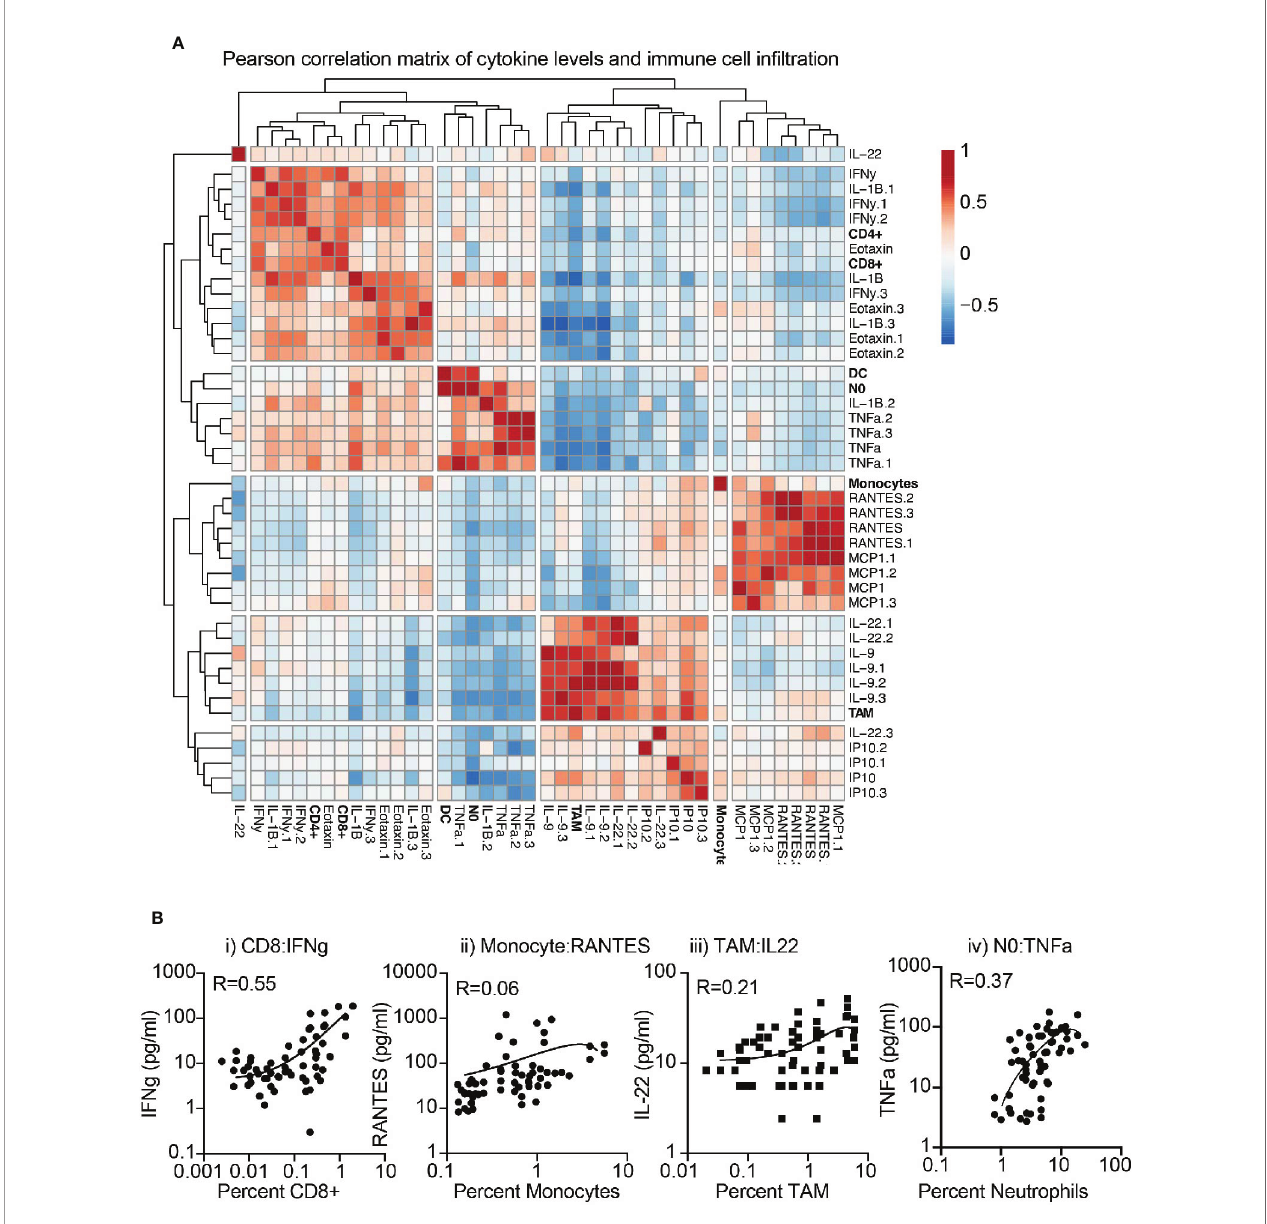
FIGURE 3 | Correlation between immune in fi ltration and baseline cytokine and chemokine secretion from tumor explants. (A) Baseline cytokine and chemokine secretion detected by multiplex assay and matching immune in fi ltration determined by fl ow cytometry were analyzed for their correlation. Pearson correlation scores were clustered to identify potential coregulated features. Rows are centered; no scaling is applied to rows. Both rows and columns are clustered using maximum distance and average linkage. 42 rows, 42 columns. (B) Examples of correlated cytokines or chemokines with i) CD8 T cells, ii) Monocytes, iii) macrophages (TAM), and iv) Neutrophils